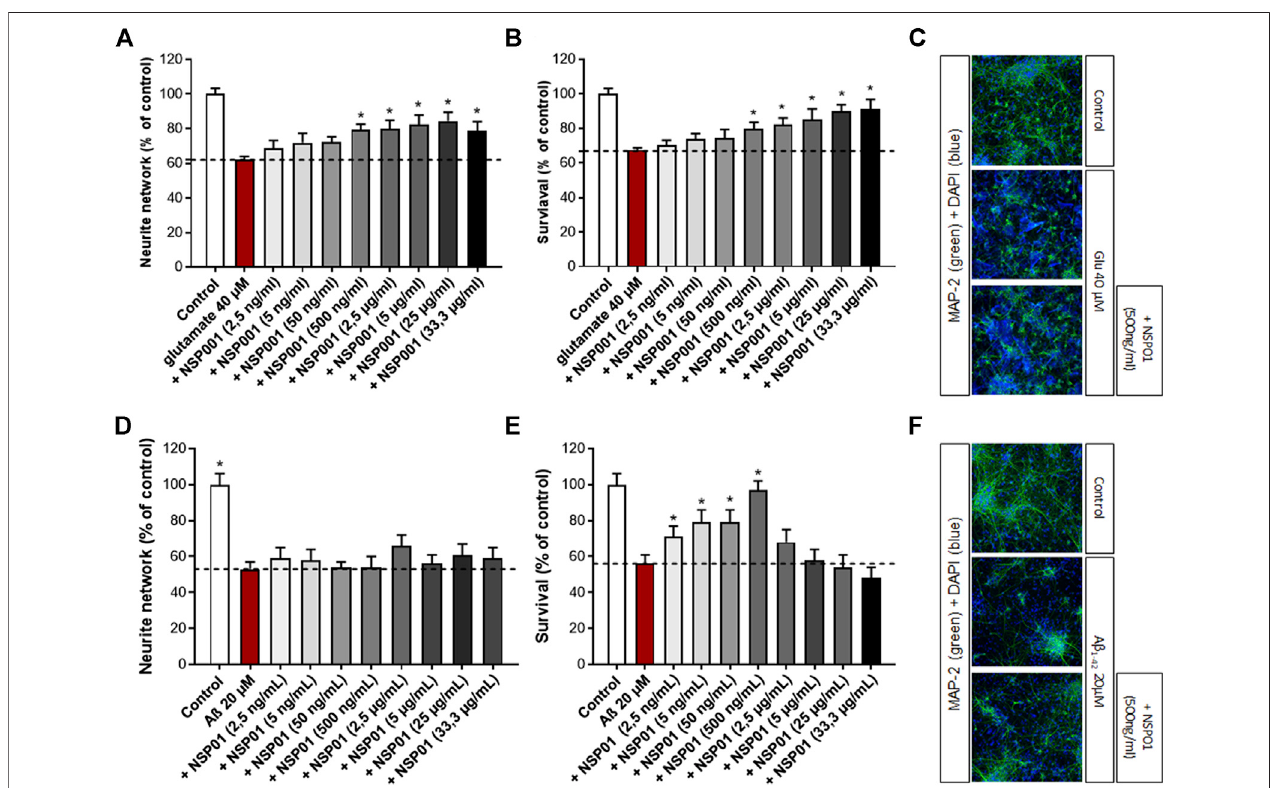
FIGURE 2 | Neuroprotective activity of NSP01 H. serrata extracts. Neurite network and cell survival were measured in primary rat cortical neurons by immunohistochemistry (MAP-2 antibody). (A,B) , immunohistochemical quanti fi cation of MAP-2 in neurons injured with glutamate (40 μ M, 20 min) and pre-treated with severaldosesofNSP01extractfor48 h. (C) ,representativeMAP-2staining(green)ofprimaryratcorticalneuronsinjuredwith40 µMofglutamate.500 ng/mlofNSP01, containingtheequivalentof2,9 nMHA,0,7 nMofCAand1,7 nMofFA,representsthe fi rsteffectivedoseleadingtoneuroprotection. (D – F) ,immunohistochemical quanti fi cationandpicturesofMAP-2inneuronsinjuredwithA β 1-42 oligomers(20 μ M,24 h)andpre-incubatedwithseveraldosesofNSP01extract(1 h).Thebesteffect was obtained after treatment with 500 ng/ml of extract. All values are expressed as mean ± SEM (standard error of the mean). * p < 0.05 vs.